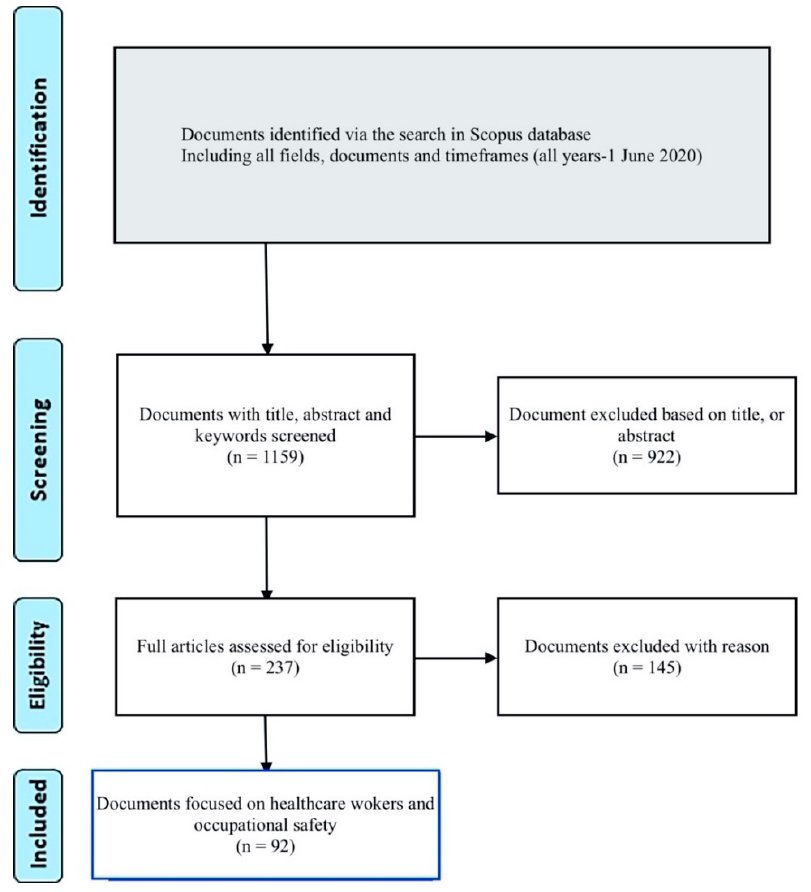
Figure 1. Flow diagram for the selection of articles for bibliometric analysis based on the topic and population.